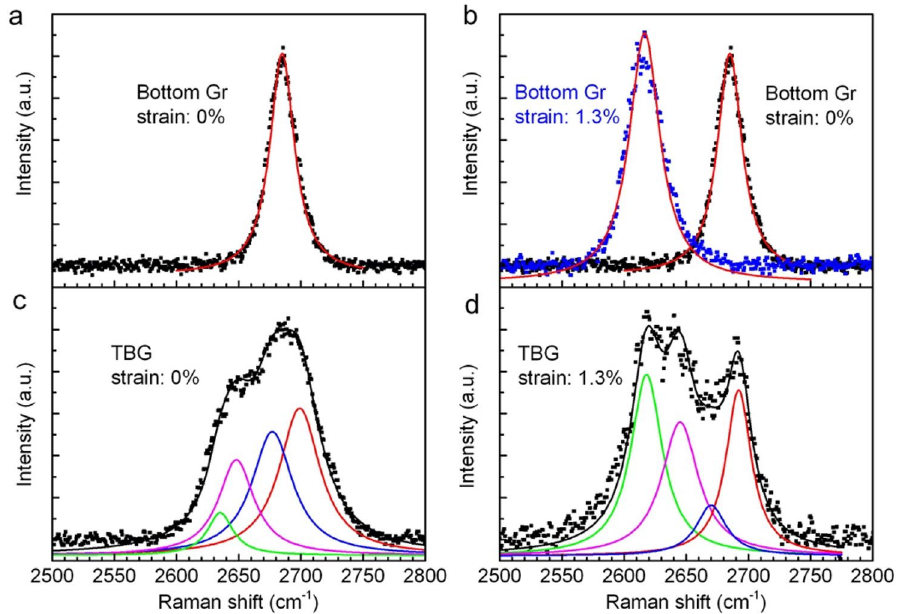
Figure 3. Raman spectra of graphene 2D peak give evidence of weak electronic coupling in TBG and heterostrained TBG. ( a ) Raman spectrum of 2D peak in unstrained bottom graphene. ( b ) Raman spectrum of 2D peak in bottom graphene under 1.3% uniaxial strain (blue dots). 2D spectrum of unstrained graphene was added for reference. ( c ) Raman spectrum of 2D peak in unstrained TBG. ( d ) Raman spectrum of 2D peak in TBG under 1.3% heterostrain. Dots are experimental data and curves are obtained by Lorentz